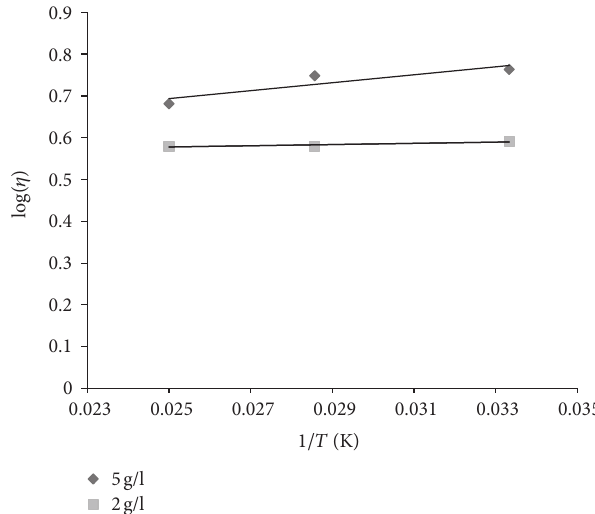
F 4: Arrhenius-Frenkel-Eyring plots for 2 and 5 tions of FP